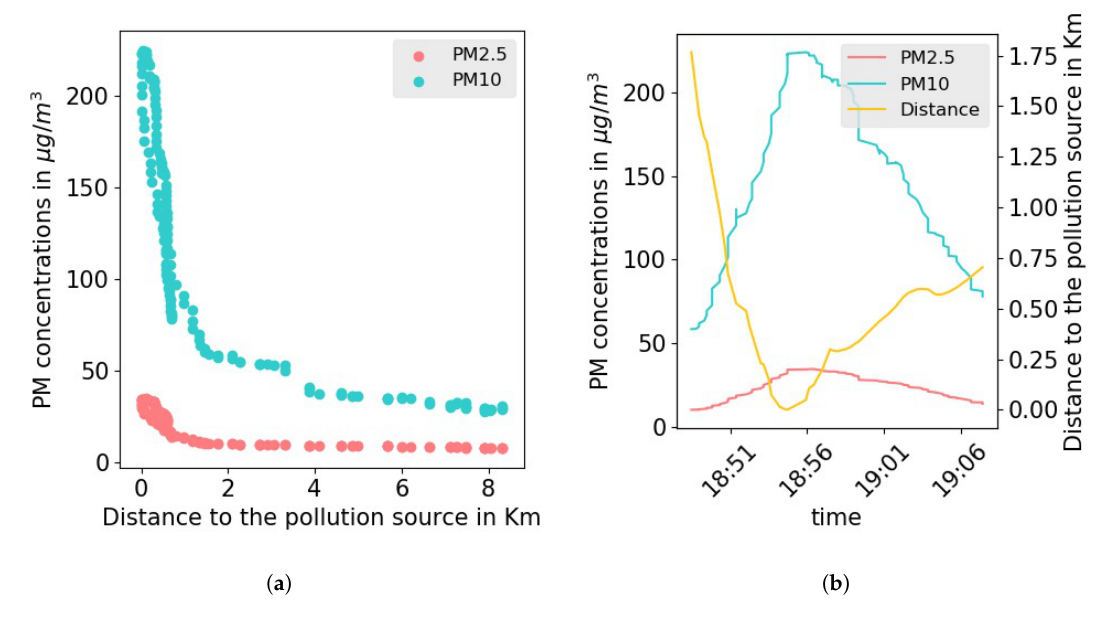
Figure 6. PM concentrations vs distance to the area of